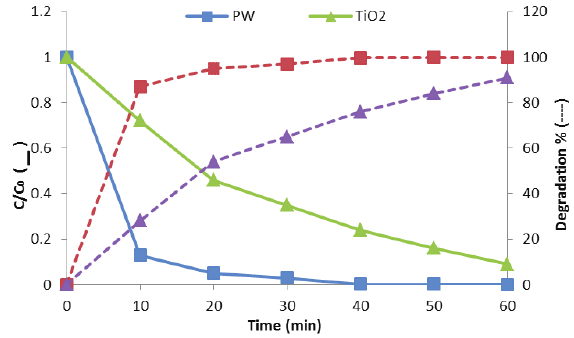
Figure 10: Comparison of photocatalytic degradation of MB solution under UV irradiation using praseodymium tungstate (PW) and Degussa P25 TiO as photocatalysts. 2